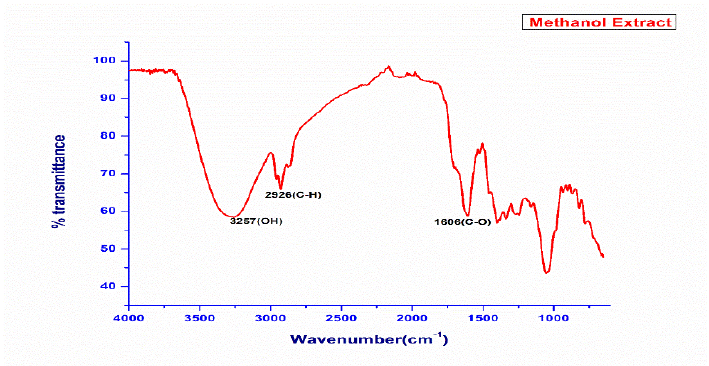
Figure 3. FTIR spectral analysis of methanol extract of plant Nymphaea Mexicana Zucc.